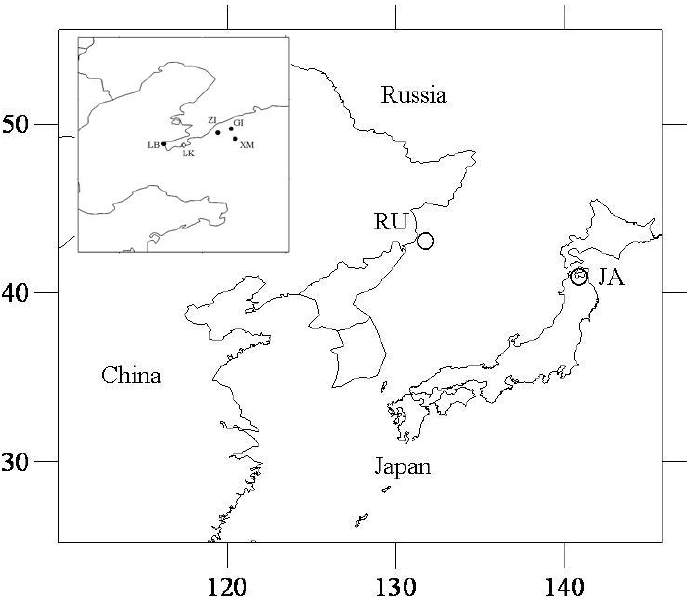
Figure 1. Map showing locations and abbreviated names for four hatchery samples (●) and three natural (○) Japanese scallop samples.